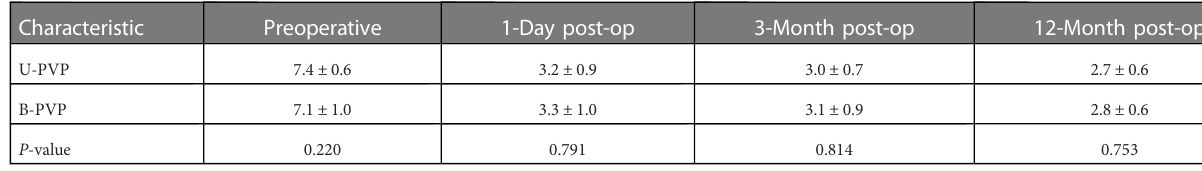
TABLE 2 The changes of VAS scores during follow-up period.